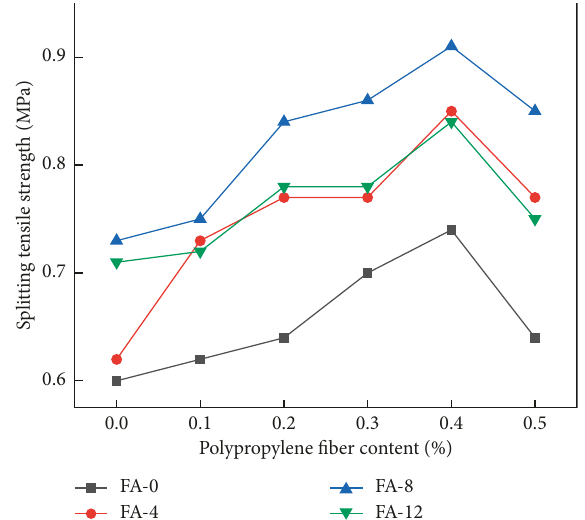
Figure 6: Relationship between splitting tensile strength and polypropylene fiber content.